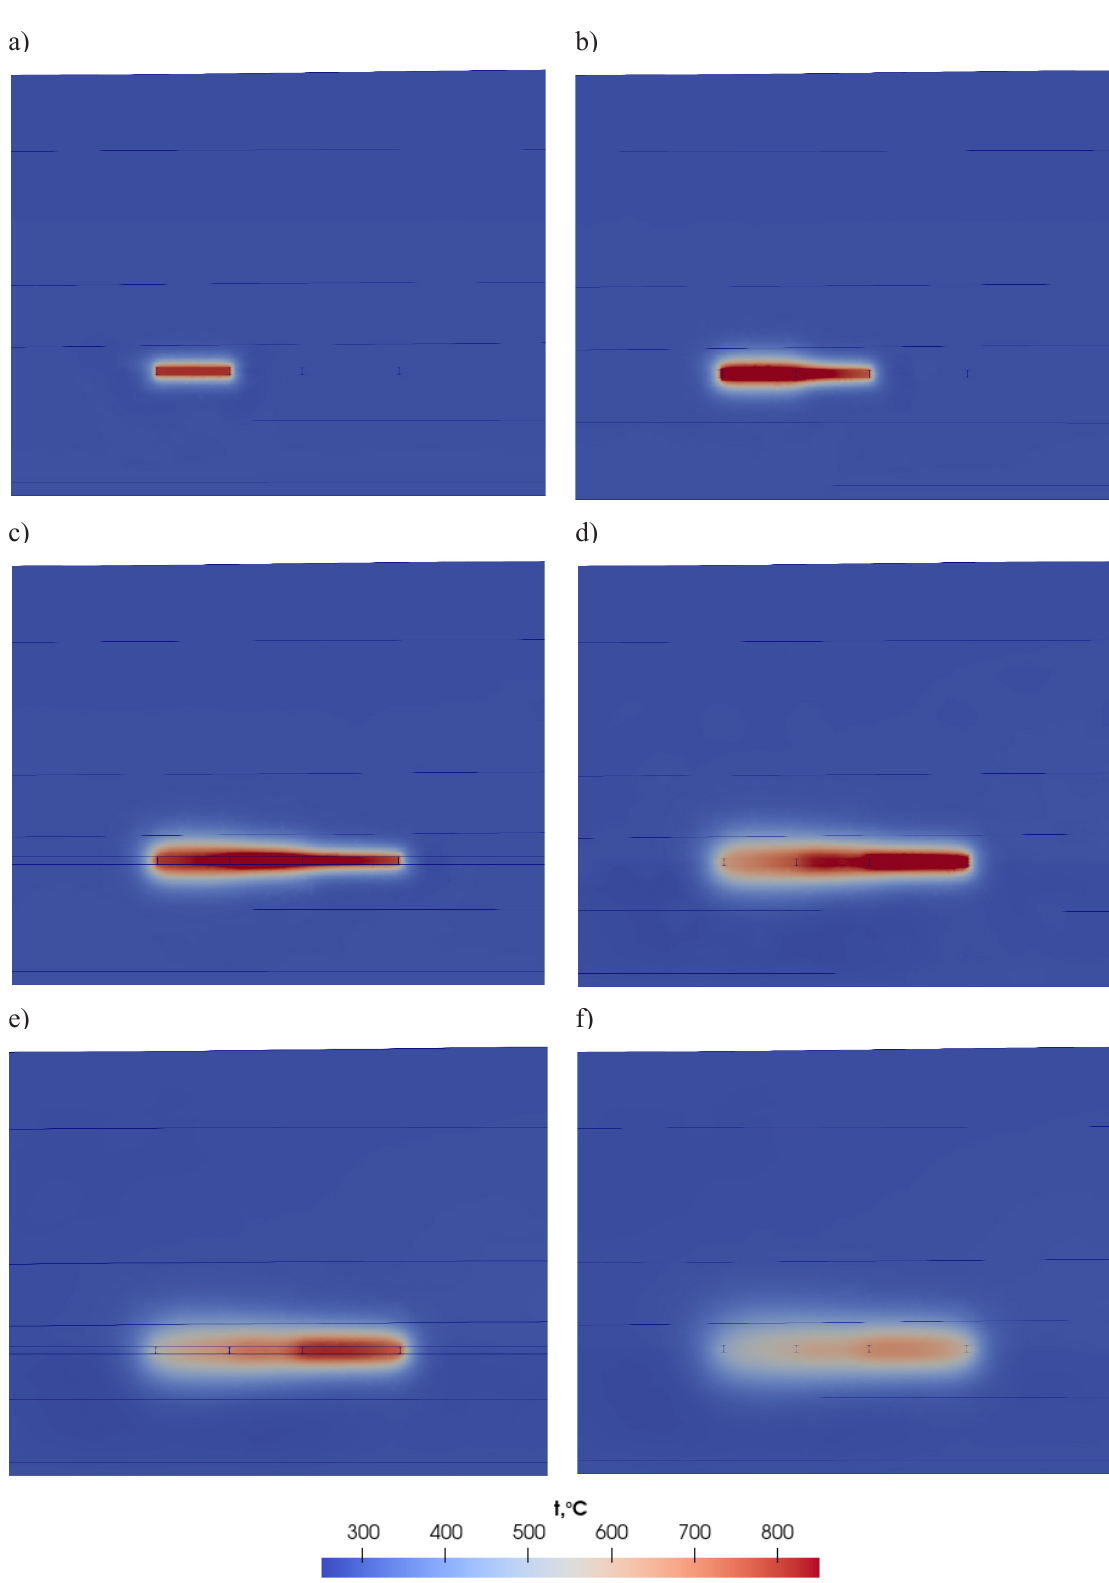
Figure 6: Evolution of temperature changes around the coal gasification generator over time: a) start, b) 0.5 year, c) 1 year , d) 1.5 year, e) 2 year, f) 2.5